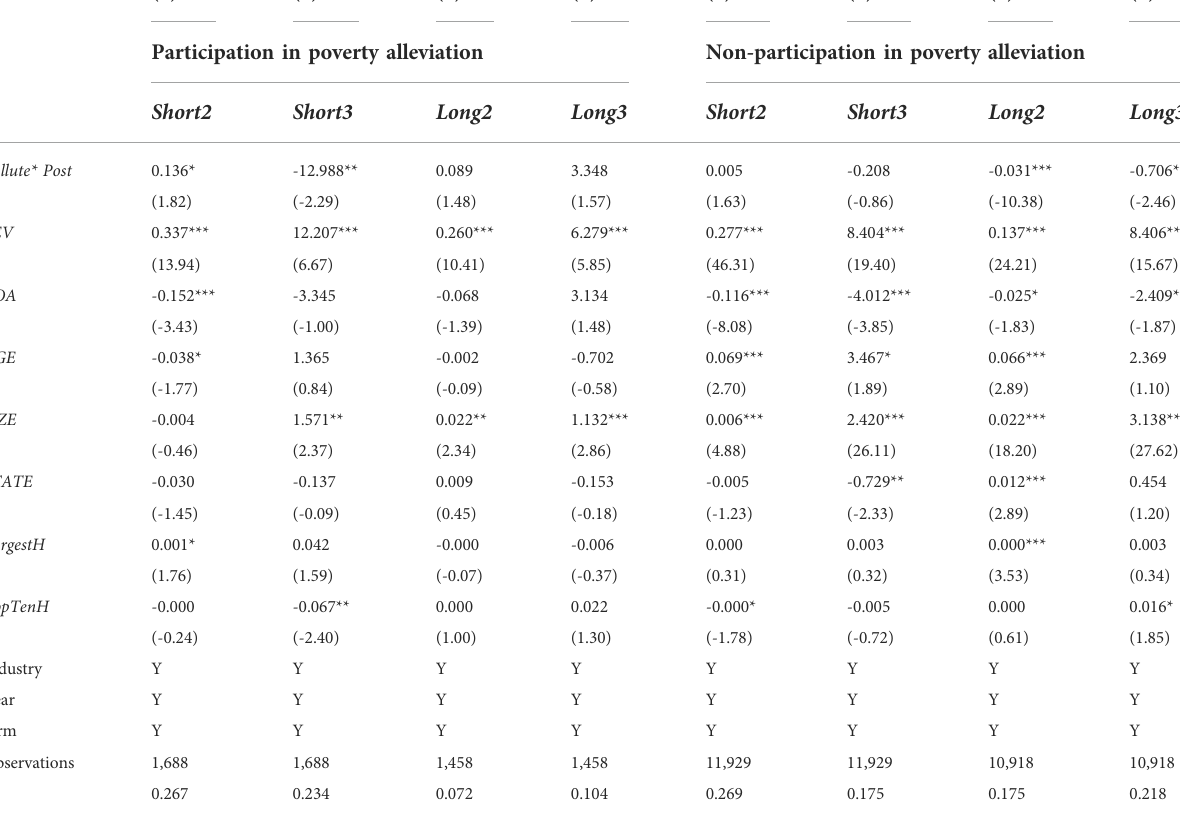
TABLE10 Replacing metrics of corporate participation in poverty alleviation.